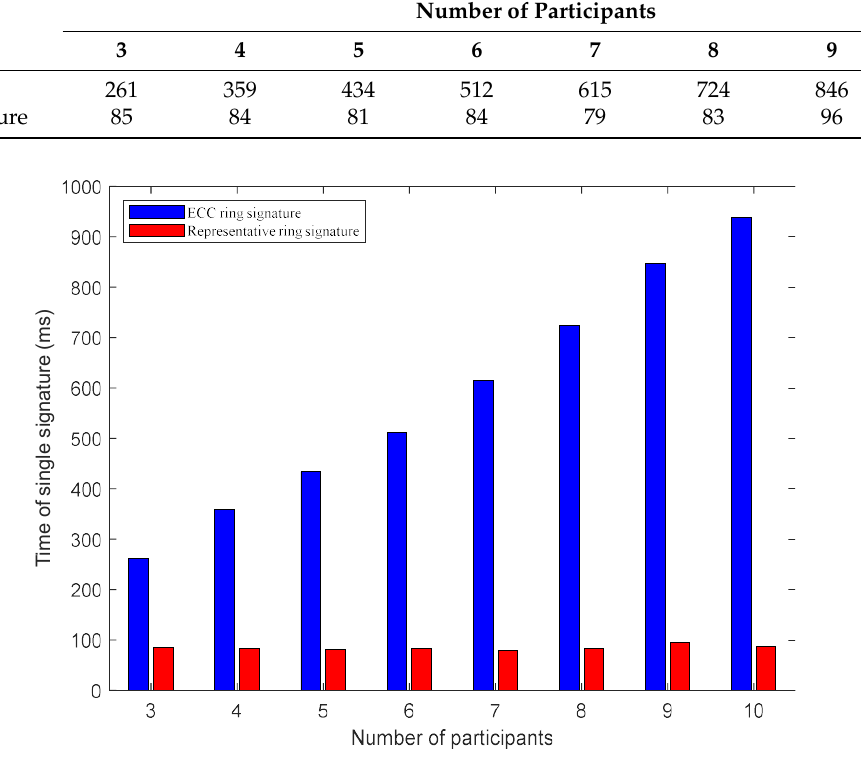
Figure 7. The comparison of single signatures in terms of computational speed.